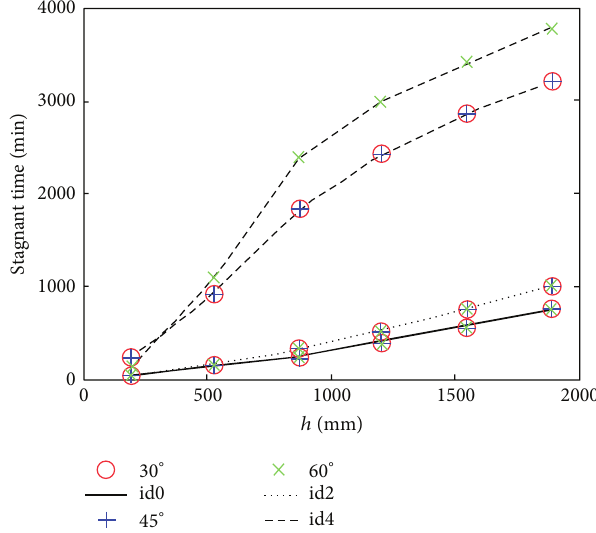
Figure 13: Simulation results about the mean stagnant time of the marking pebbles id0, id2, and id4, on the cone angles 30 ∘ , 45 ∘ , and 60 ∘ ( 𝑓 = 0.2 , ℎ = 160